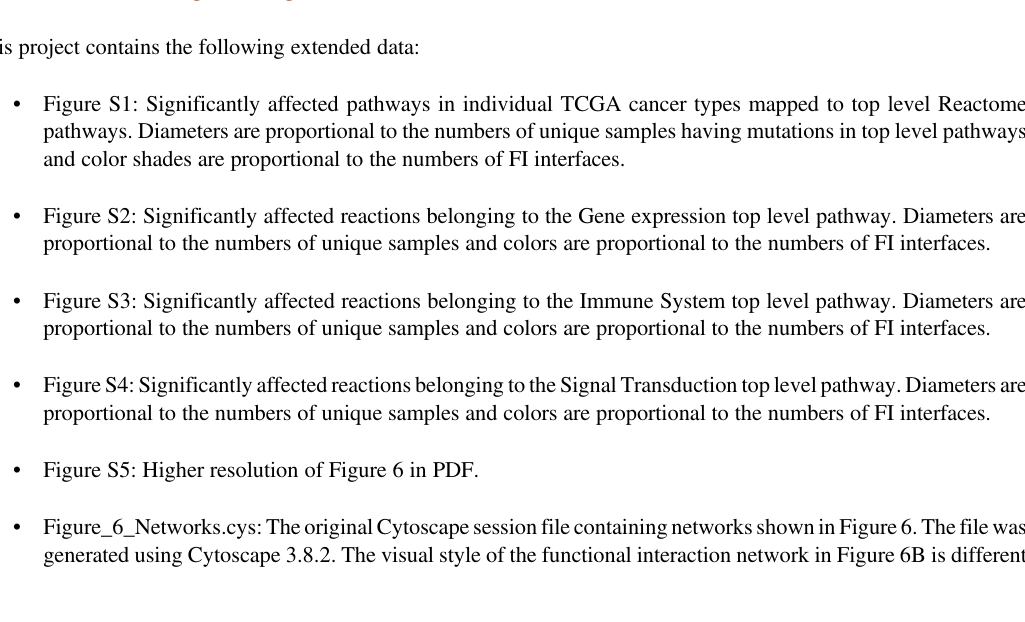
(cid:129) Figure S1: Significantly affected pathways in individual TCGA cancer types mapped to top level Reactome pathways. Diameters are proportional to the numbers of unique samples having mutations in top level pathways and color shades are proportional to the numbers of FI interfaces. (cid:129) Figure S2: Significantly affected reactions belonging to the Gene expression top level pathway. Diameters are proportional to the numbers of unique samples and colors are proportional to the numbers of FI interfaces. (cid:129) Figure S3: Significantly affected reactions belonging to the Immune System top level pathway. Diameters are proportional to the numbers of unique samples and colors are proportional to the numbers of FI interfaces. (cid:129) Figure S4: Significantly affected reactions belonging tothe Signal Transduction top level pathway. Diameters are proportional to the numbers of unique samples and colors are proportional to the numbers of FI interfaces. (cid:129) Figure S5: Higher resolution of Figure 6 in PDF. (cid:129) Figure_6_Networks.cys: Theoriginal Cytoscapesessionfile containingnetworks showninFigure6.Thefilewas generated using Cytoscape 3.8.2. The visual style of the functional interaction network in Figure 6B is